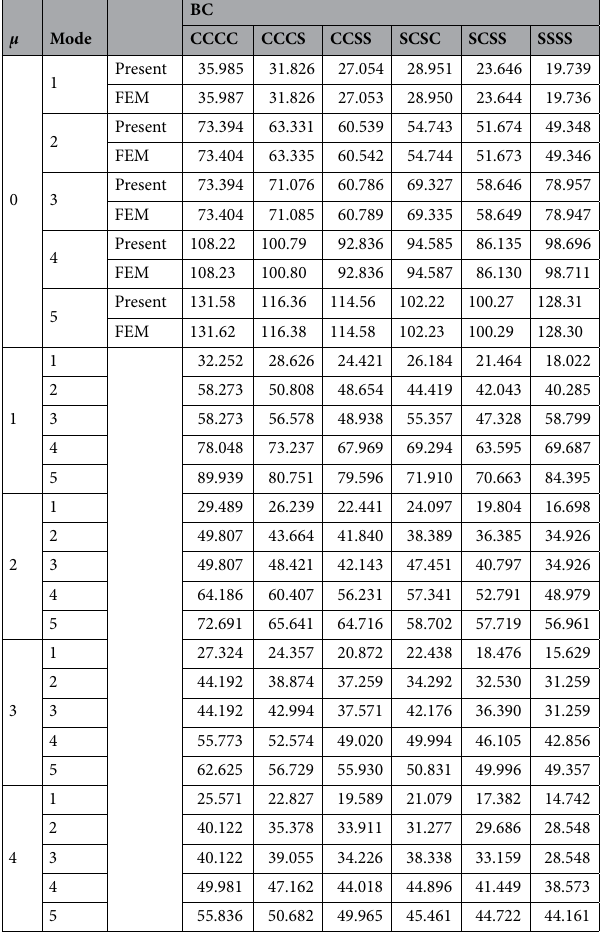
Table 6. Frequency parameters, ω b